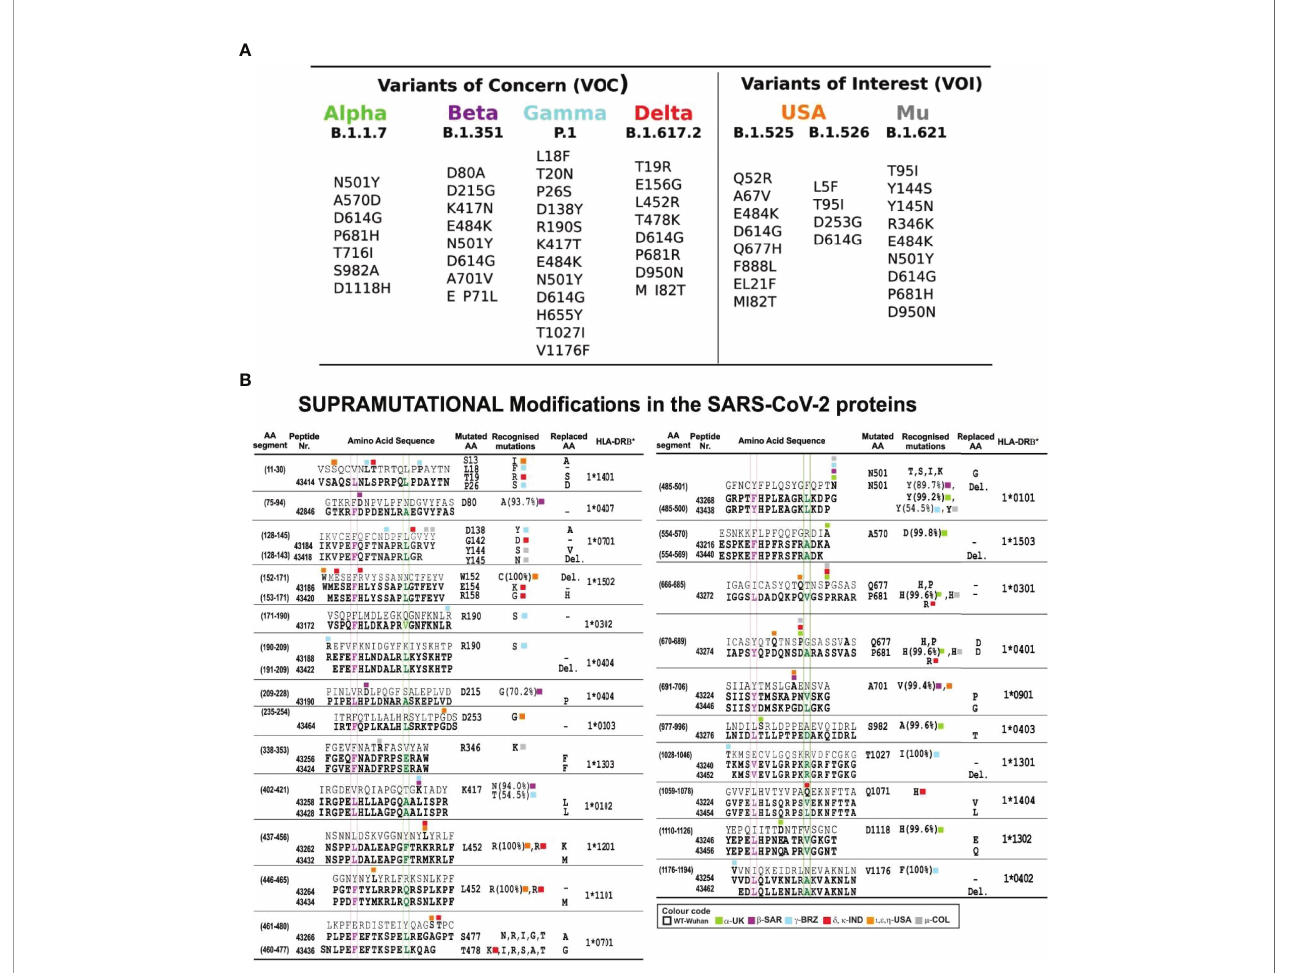
FIGURE 7 | Most frequently occurring mutant residues in VOC and VOI. (A) VOC mutations: a , b , g , and d and VOI USA and m from www.cov-lineages.org. (B) FIDIC ’ s serial peptide numbers (grouped according to exclusive or common presence). Numbers in parenthesis show their location in the aa sequence; above, native parental aa sequence, below (bold), modi fi ed peptides. Residues fi tting into the HLA-DR b 1* P1-P9 boxed in fuchsia and green as reference and modi fi ed peptides with residues boxed, coloured according to the variants ’ colour code in bold. The mutated aa column shows mutant residue variants, where fi rst identi fi ed and their frequency in %; the last column shows the HLA-DR b 1* allele they bound to after modi fi cation. Colours show different VOC, VOI, and VUM variants. Native peptides did not bind HLA-DR b 1* molecules or had low BA ( Figure 4